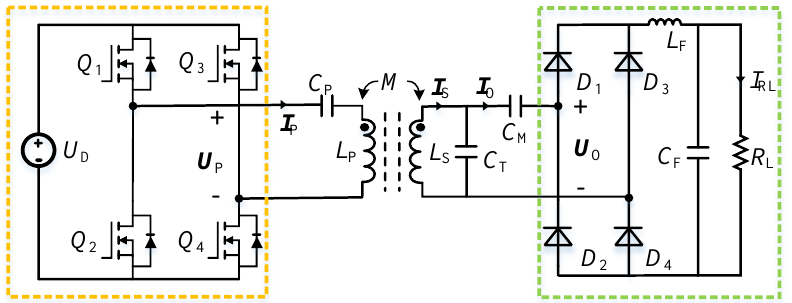
Figure 2. Circuit diagram of the S/PS − compensated WPT System.